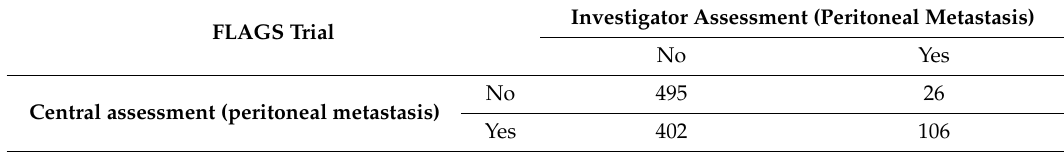
Table 3. Discrepancy between central and individual investigator assessment in the FLAGS